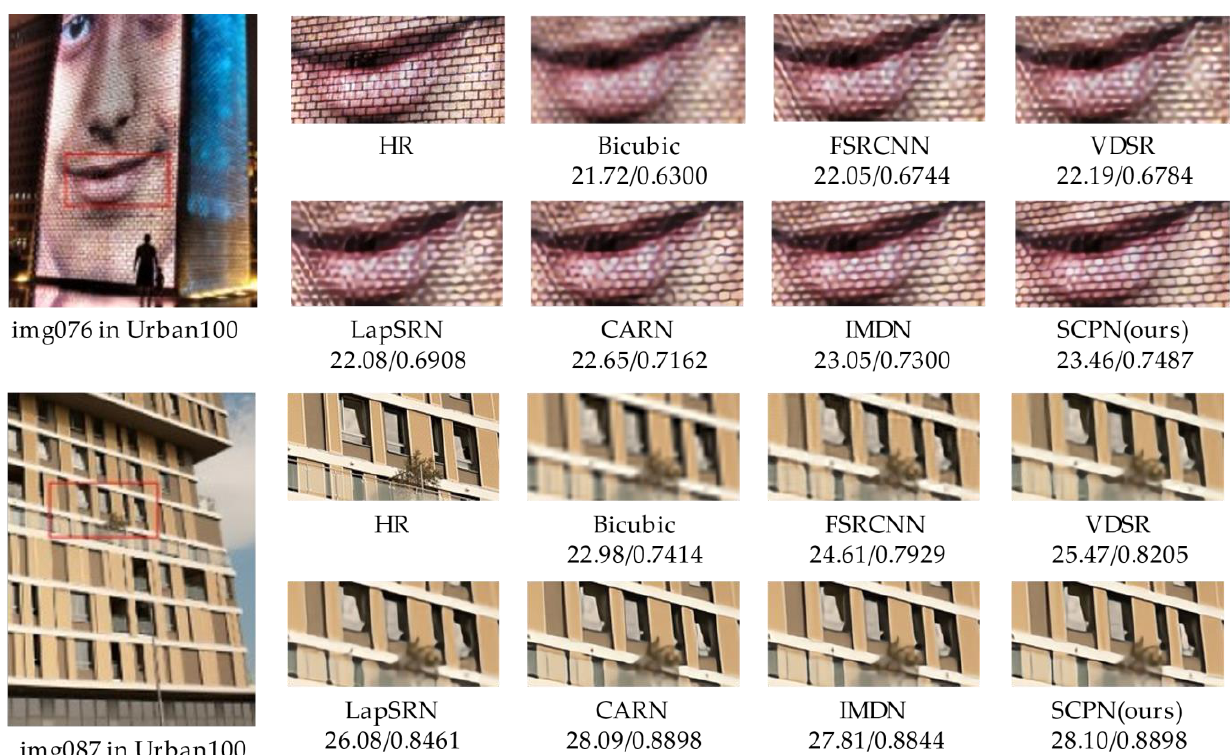
Figure 9. Qualitative results for ×4 SR. The numbers under the name of methods means the PSNR and SSIM values of the corresponding